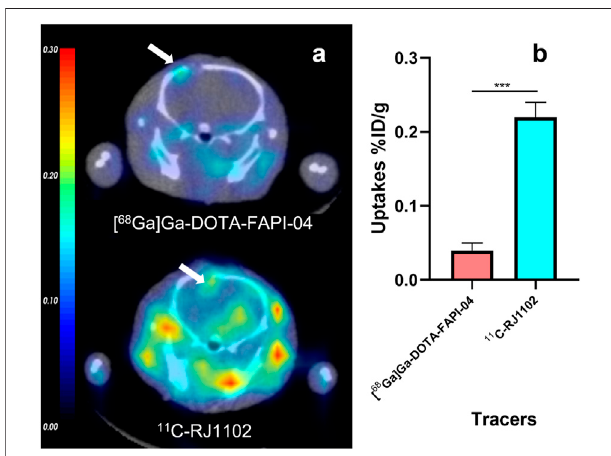
FIGURE6| TheorthotopicxenograftgliomasmodelsmallanimalPETof 11 C-RJ1102 and ( 68 Ga) Ga-DOTA-FAPI-04 at 60 min p.i. (A) The representative static PET imaging of 11 C-RJ1102 and ( 68 Ga) Ga-DOTA-FAPI- 04at 60 minp.iinU87MG orthotopic xenograft gliomasmodels. (B) The uptakes of 11 C-RJ1102 and ( 68 Ga) Ga-DOTA-FAPI-04 in tumor.